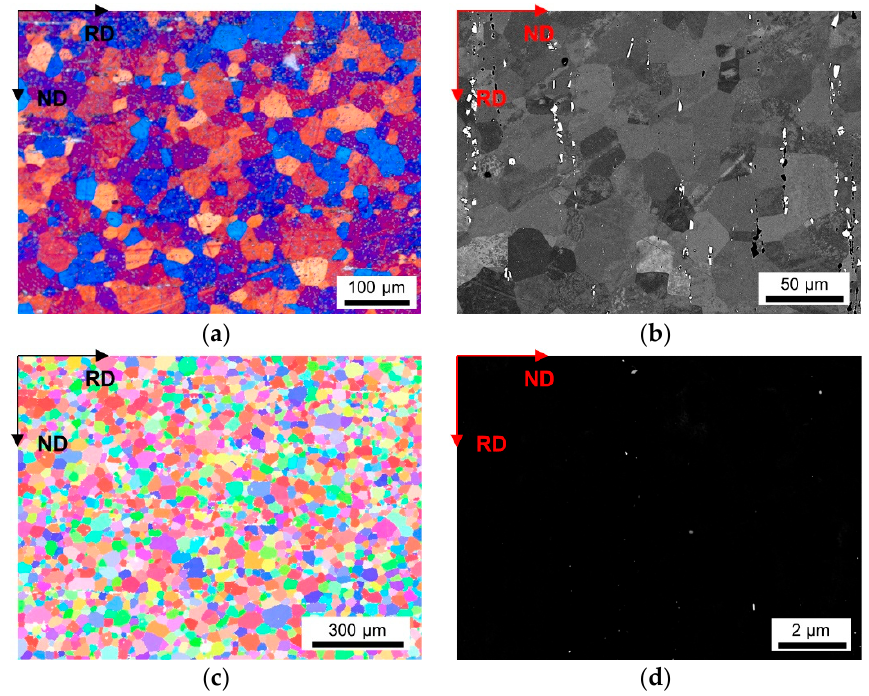
Figure A17. Microstructure of the soft annealed HFe-LMn cast under S-C conditions, homogenized at 500 °C and cold rolled to a CRD of 63%. ( a ) LOM. ( b ) BSE image. ( c ) EBSD IPF map in RD–ND plane. ( d ) BSE micrograph showing dispersoids.